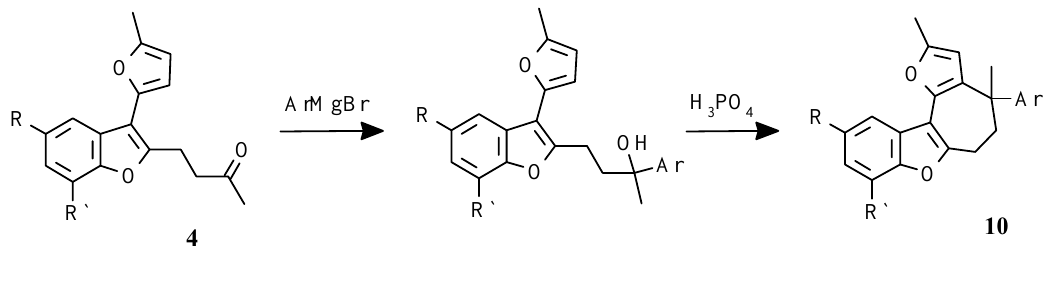
Scheme 13. Ar = phenyl; p-anisyl;